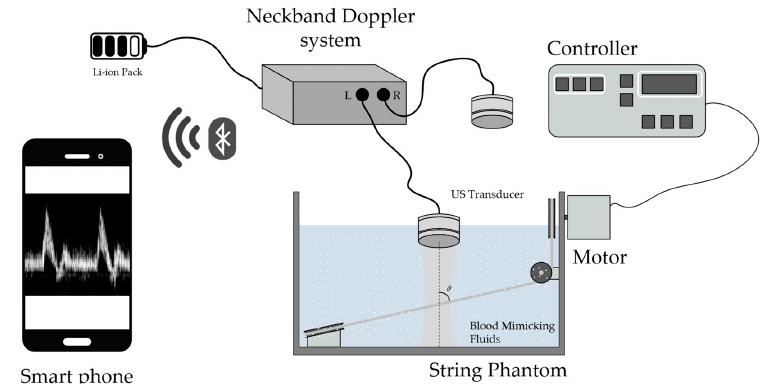
Figure 3. Experimental setup for the Doppler string phantom.